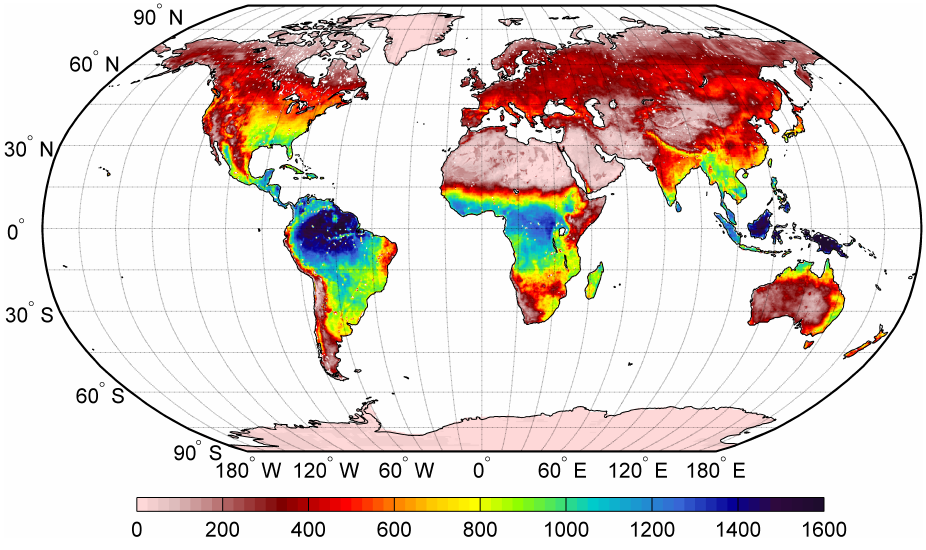
Fig. 8. GLEAM E for 2005 (in mm).